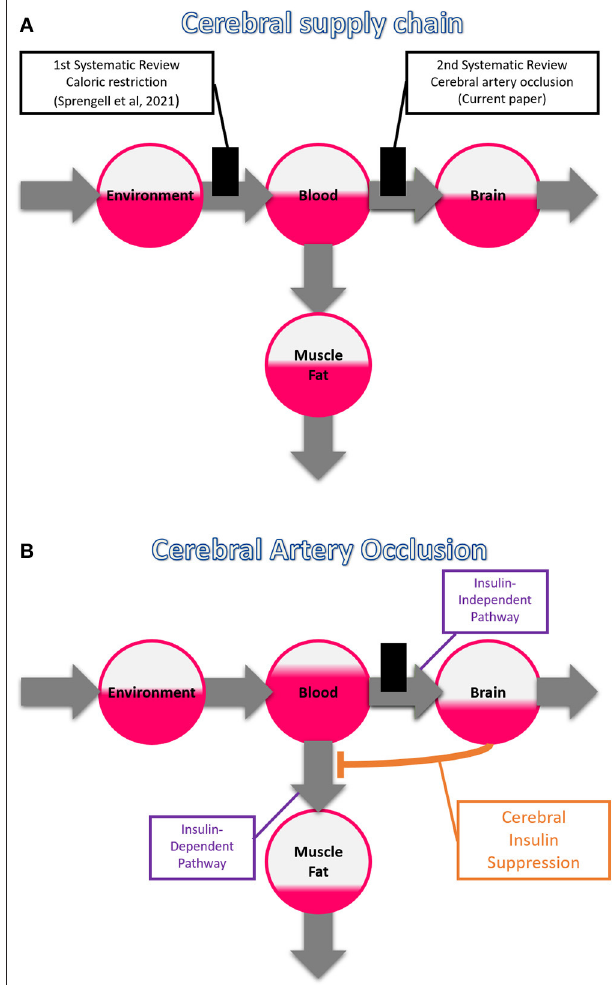
FIGURE 2 | The branched cerebral supply chain. The branching originates from the blood, transmitting energy either to the brain or to muscle or fat tissue. (A) Systematic reviews on two different bottlenecks in the cerebral supply chain. The first one deals with a distal bottleneck, i.e. caloric restriction, and is already published (Sprengell et al., 2021); the second one, the current work, deals with a proximal bottleneck, i.e. cerebral artery occlusion. (B) Cerebral insulin suppression induced by cerebral artery occlusion. Intraneuronal ATP depletion activates the sympathetic nervous system and the hypothalamic-pituitary-adrenal axis, which both rigorously suppress pancreatic ß-cell secretion, and in so doing block insulin-dependent glucose uptake in muscle and fat tissue. The portion of glucose that is prevented from entering muscle and fat tissue accumulates in the blood, facilitating transfer across the blood-brain barrier via the insulin-independent pathway, allowing partial compensation when brain supply is compromised.